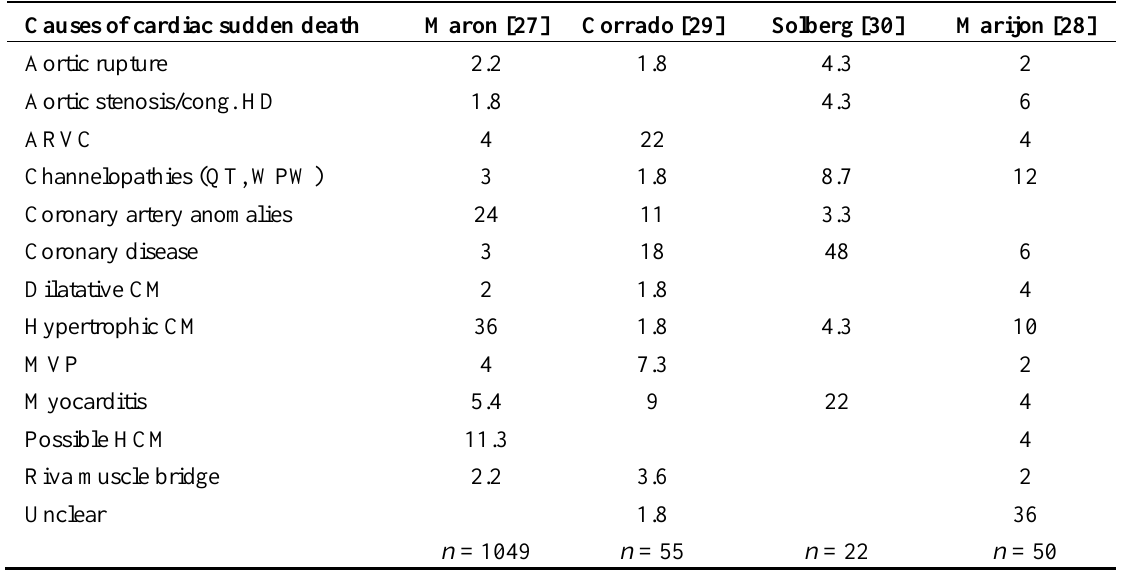
Table 10. Causes of sudden cardiac death in young athletes 12–35 years old (percentages). Causes of cardiac sudden death Maron [27] Corrado [29] Solberg [30] Marijon [28] Aortic rupture 2.2 1.8 4.3 2 Aortic stenosis/cong. HD 1.8 4.3 6 ARVC 4 22 4 Channelopathies (QT, WPW) 3 1.8 8.7 12 Coronary artery anomalies 24 11 3.3 Coronary disease 3 18 48 6 Dilatative CM 2 1.8 4 Hypertrophic CM 36 1.8 4.3 10 MVP 4 7.3 2 Myocarditis 5.4 9 22 4 Possible HCM 11.3 4 Riva muscle bridge 2.2 3.6 2 Unclear 1.8 36 n = 1049 n = 55 n = 22 n = 50 cong. HD = congenital heart disease; ARVC = arrhythmogenic right ventricular cardiomyopathy; QT = QT-syndrome (including Romano-Ward syndrome and Jervell-Lange-Nielsen syndrome); WPW = Wolff-Parkinson-White syndrome; CM = cardiomyopathy; HCM = hypertrophic cardiomyopathy; MVP = mitral valve